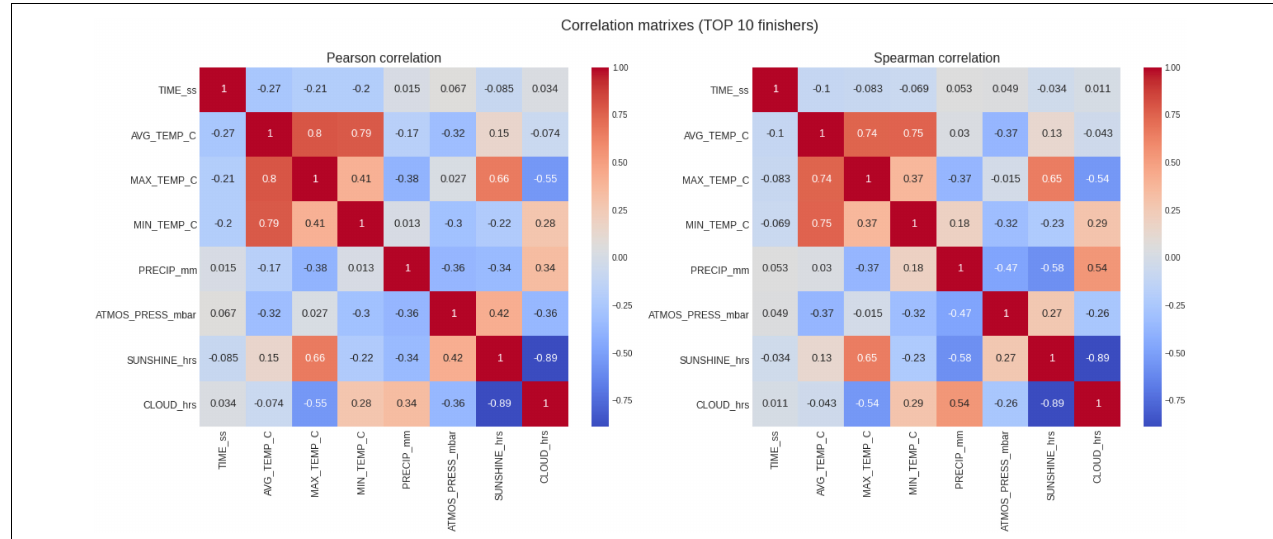
FIGURE 5 | Analysis of the correlation of the target variable (marathon race time) and the descriptive variables (weather conditions) for the top 10 runners. PRECIP, precipitation in mm, SUNSHINE duration in hours, CLOUD cover in hours; ATMOS_PRESS, atmospheric pressure in mbar; AVG_TEMP, average temperature in degrees Celsius; MAX_TEMP, maximum temperature in degrees Celsius; MN_TEMP, minimum temperature in degrees Celsius.